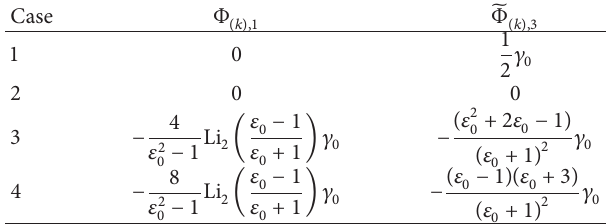
̃Φ (𝑘),3 calculated in Section 4.5